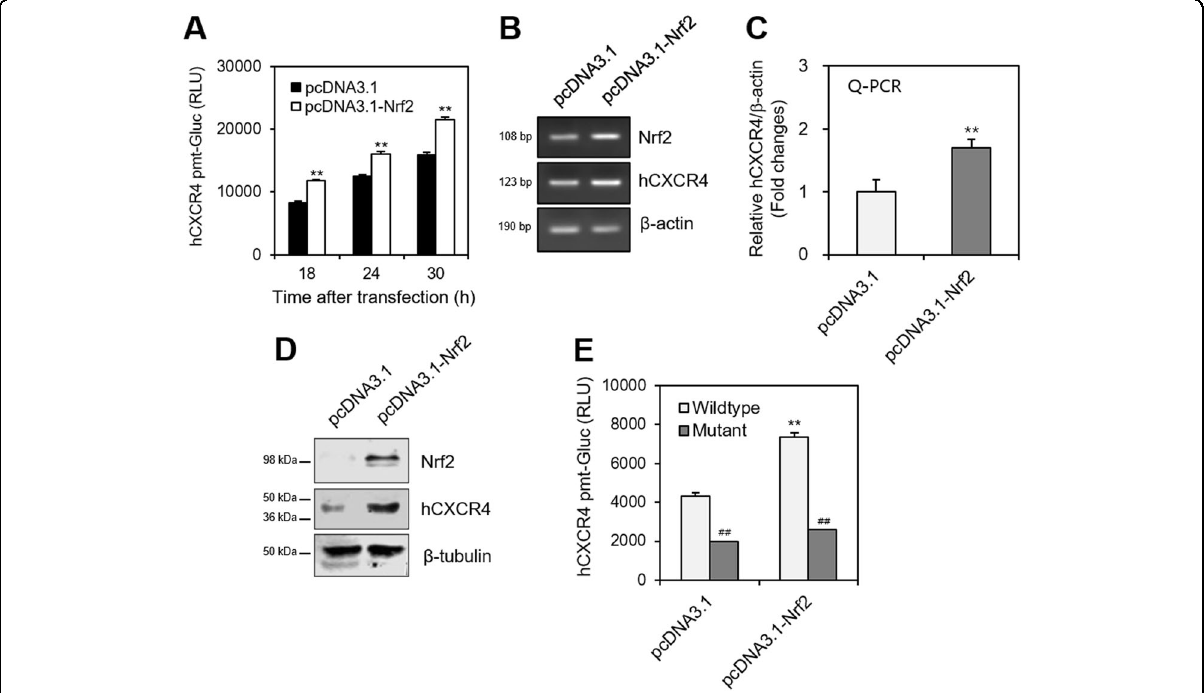
Fig. 5 hCXCR4 expression was increased by Nrf2 overexpression. A – D WiL2-NS cells were co-transfected with pEZX-PG02-hCXCR4-gaussia luciferase (Gluc) plasmid DNA with pcDNA3.1 control or pcDNA3.1-Nrf2 plasmids using Viafect ™ . 30 h after transfection, Gluc activity of hCXCR4 promoter (pmt) was measured by using luminometer ( A ). RNA was extracted by using Nucleozol. mRNA of hCXCR4 was measured by RT-PCR ( B ) or qPCR ( C ). Cell lysates were prepared and the protein level of each protein was measured by using western blot analysis ( D ). E WiL2-NS cells were co- transfected with wild or mutant type of pEZx-PG02-hCXCR4-Gluc promoter plasmid DNA with pcDNA3.1 control or pcDNA3.1-Nrf2 plasmids using Viafect ™ . 30 h after transfection, WiL2-NS cells were incubated under hypoxic condition and Gluc activity was measured by using luminometer. Each experiment was performed at least fi ve times. Data in a bar graph represented the means ± SD. * p < 0.05, ** p < 0.01; signi fi cantly different from pcDNA3.1-transfected control group. # p < 0.05, ## p < 0.01; signi fi cantly different from control transfected with wildtype CXCR4 pmt plasmid ( A , C , E